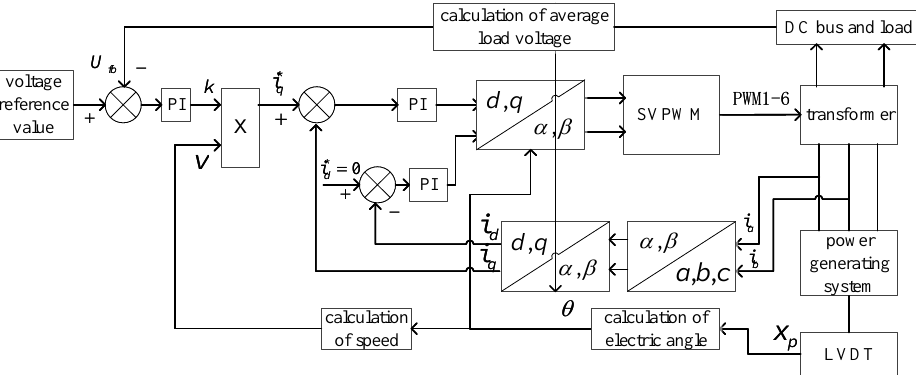
Figure 2. Block diagram of double closed-loop generation system control strategy.